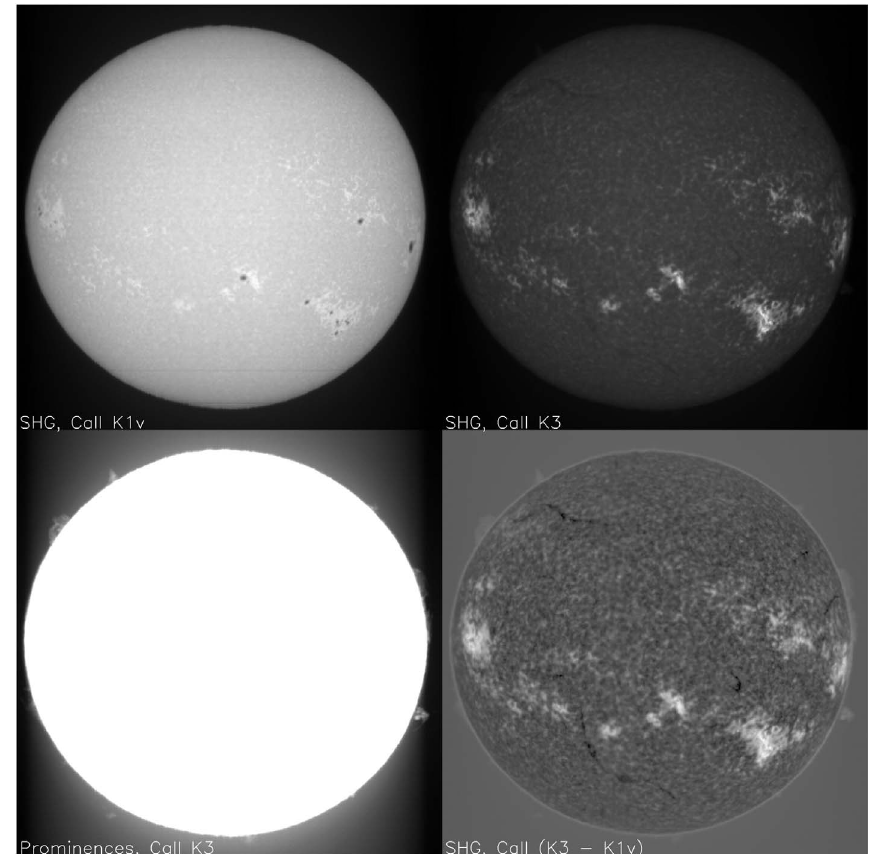
Fig. 8. Typical images issued from CaII K datacubes of the Spectroheliograph. Top (left to right): K1 v (blue wing, (cid:4) 1.0 Å) and K3 (line core). Bottom (left to right): limb prominences (K3) and composite image (line center minus red and blue